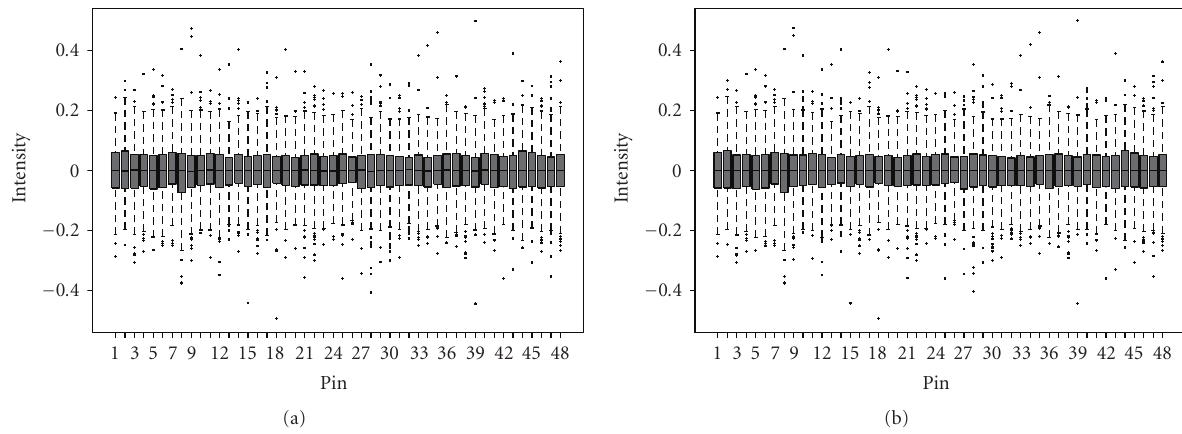
Figure 6: Spotting process: Pin: The box-plot showing the distribution of log T/C values for each pin (a) before correction and (b) after correction by median subtraction.